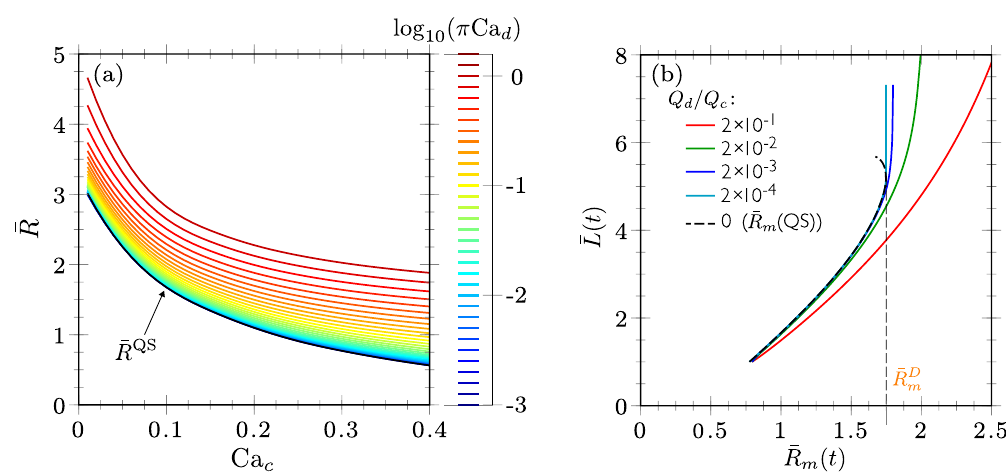
Figure 8. ( a ) Influence of the Ca d on the generated drop radius as a function of Ca c computed in transient considering couple 1 (see Table 1); ¯ R QS in black line corresponds to Ca d = 4 × 10 − 6 π − 1 , i.e. the quasi-static limit. ( b ) Transient evolution of the meniscus length ¯ L as a function of the meniscus equivalent radius ¯ R m for different values of ¯ Q = Q d / Q c and Ca c = 0.1 , considering couple 1 (see Table 1). The equivalent radius of the meniscus calculated with quasi-static simulations is plotted in black dashed